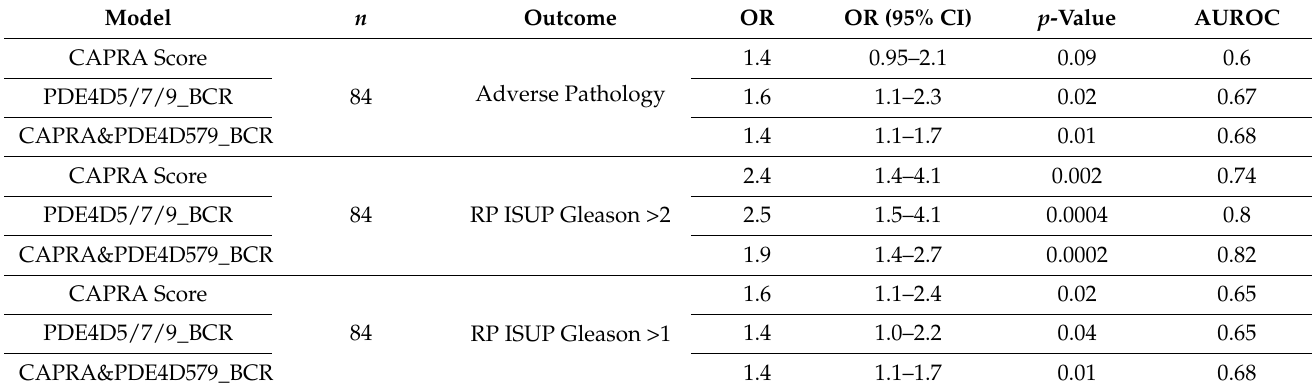
Table 3. Univariable logistic regression (UVLR) modeling of clinical and clinical-genomics risk models to post-surgical adverse pathology outcomes. The models tested were the clinical pre-surgical CAPRA score, the created logistic regression model combining the normalized PDE4D5, PDE4D7, and PDE4D9 scores (the PDE4D5/7/9_BCR model) to BCR as endpoint, the previously published CAPRA&PDE4D5/7/9_BCR risk model [24], and the active surveillance inclusion metric PRIAS [9]. The tested outcomes were: (i) Adverse Pathology defined as any ISUP pathological Gleason grade >2, or pathological pT stage > pT3a, or tumor penetrated prostate capsular status, or pN1 disease; (ii) any ISUP pathological Gleason >2; (iii) any ISUP pathological Gleason >1. OR–Odds ratio; OR (95% CI)–95% confidence interval of the Odds ratio; AUROC–Area Under the ROC